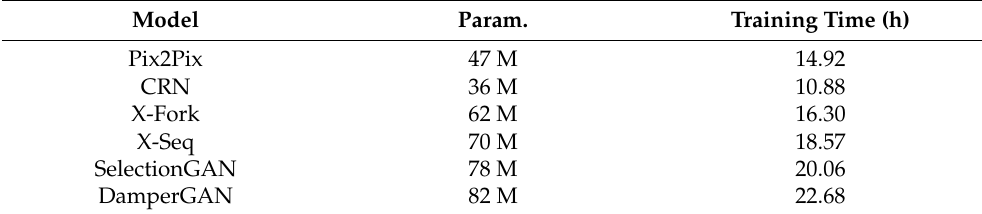
Table 10. Network parameters (Param.) and training time of the different models. Model